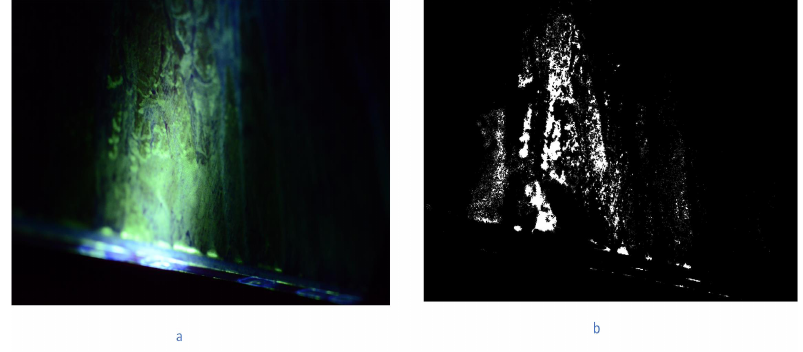
Figure 8. ( a ) Initial Image containing green areas, ( b ) Image after